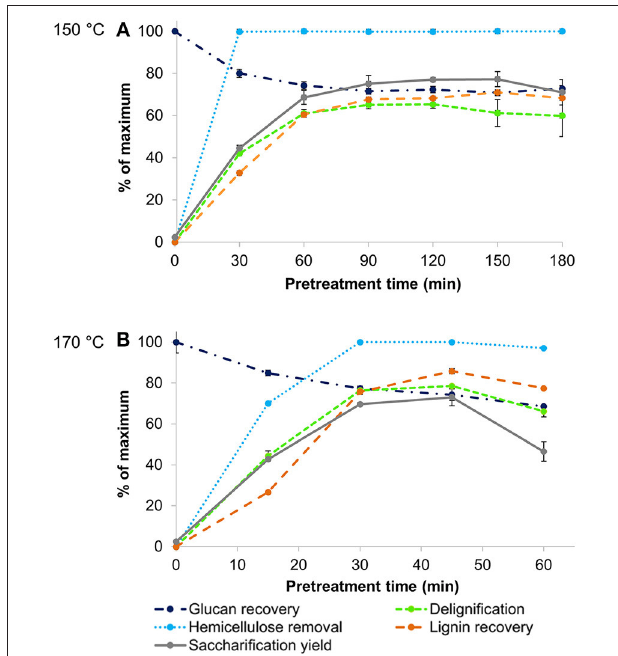
FIGURE 1 | Key indicators of pretreatment effectiveness for Ionosolv pretreatment of rice husk at (A) 150 ◦ C and (B) 170 ◦ C with [TEA][HSO 4 ], a water content of 20 wt% and a biomass to solvent ratio of 1:10